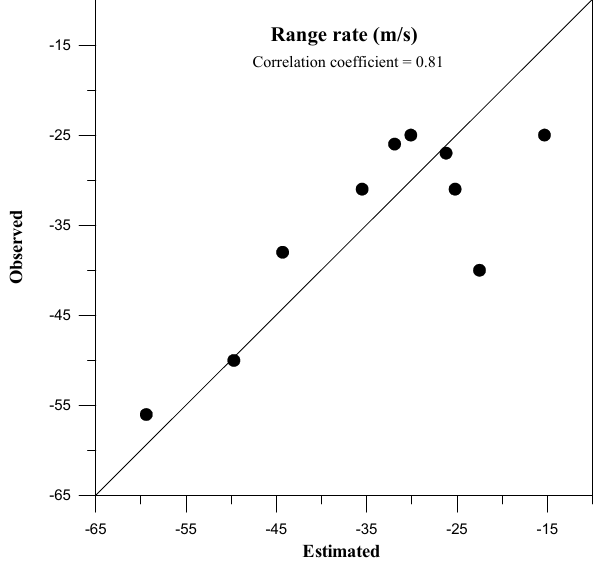
Fig. 7. Correlation of the range rates dR/dt obtained by two observ- ing methods. The ordinate displays the range rate deduced from the RTI plot (Fig. 3), and the abscissa displays the range rate estimated from Eq. (4) by the interferometry technique. the echoes when they drift into the radar volume. Take the coordinates of the target as P (x, y, z), which moves with velocity q x 2 + y 2 + z 2 , at the range R = where x=R cos θ sin φ , y=R cos θ cos φ and z=R sin θ , θ and φ are elevation and azimuth angles, respectively. Then we obtain the range rate,